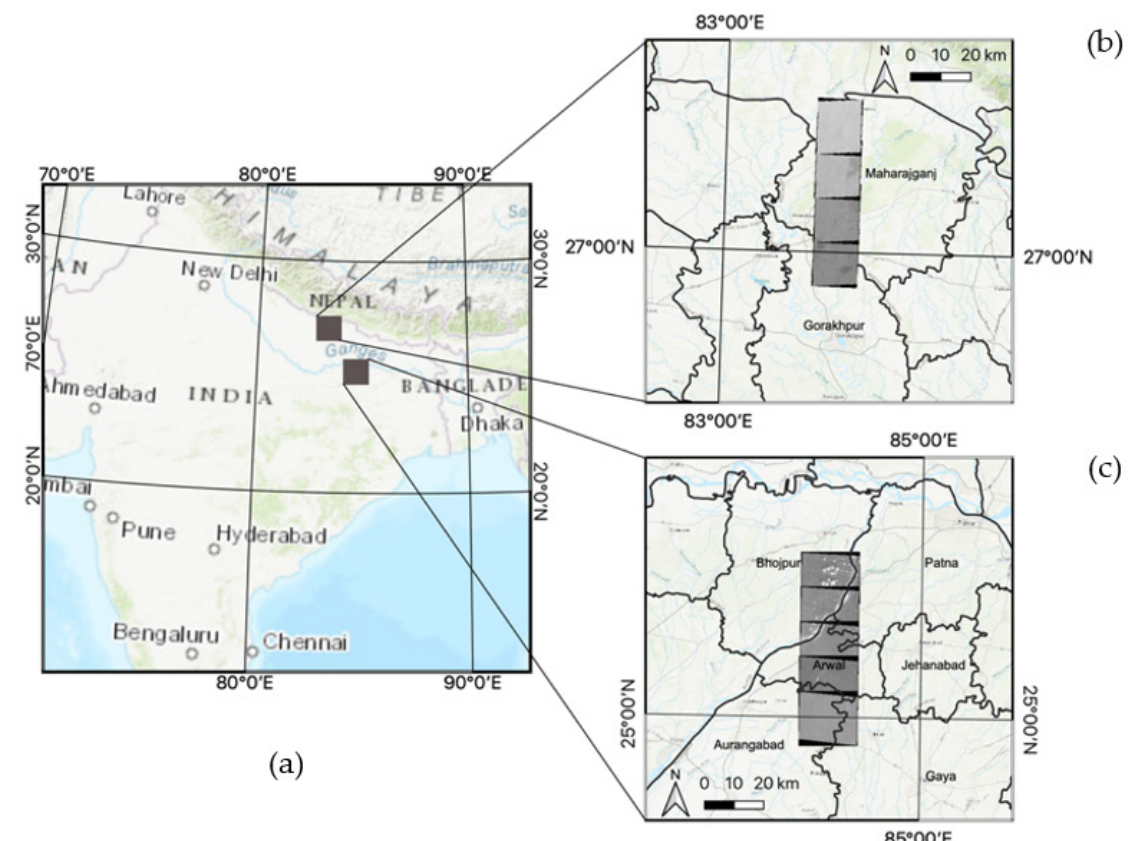
Figure 1. Panel ( a ) shows our study areas located in Bihar and Uttar Pradesh, India. Panel ( b ) shows the location of the satellite image scenes across two districts in Uttar Pradesh. Panel ( c ) shows the location of satellite image scenes across five districts in Bihar. District boundaries are shown in black. Map source: Esri Topo World .